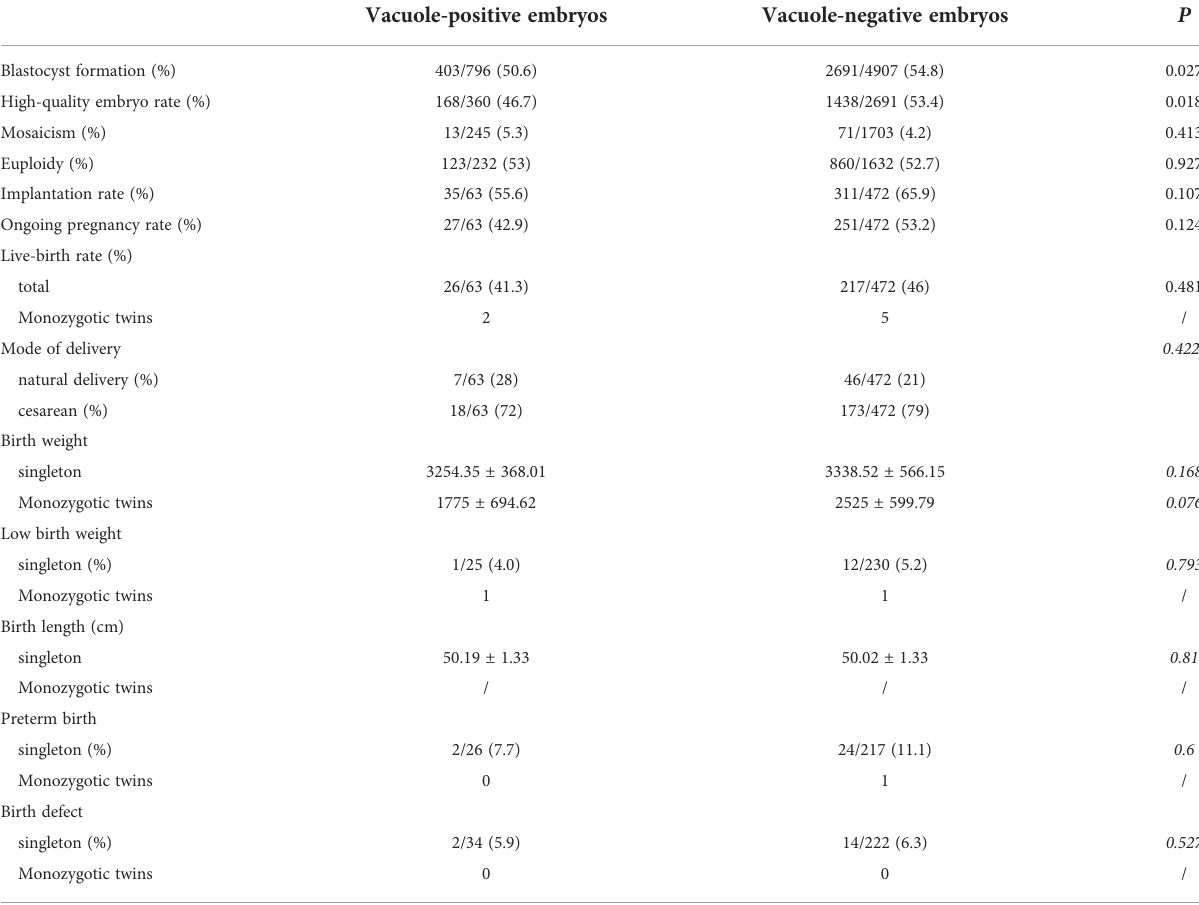
TABLE 2 Embryological, clinical, and neonatal outcomes for vacuole-positive and vacuole-negative embryos. Vacuole-positive